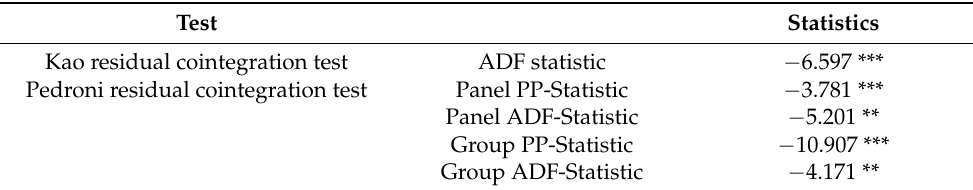
Table 5. Results of panel cointegration